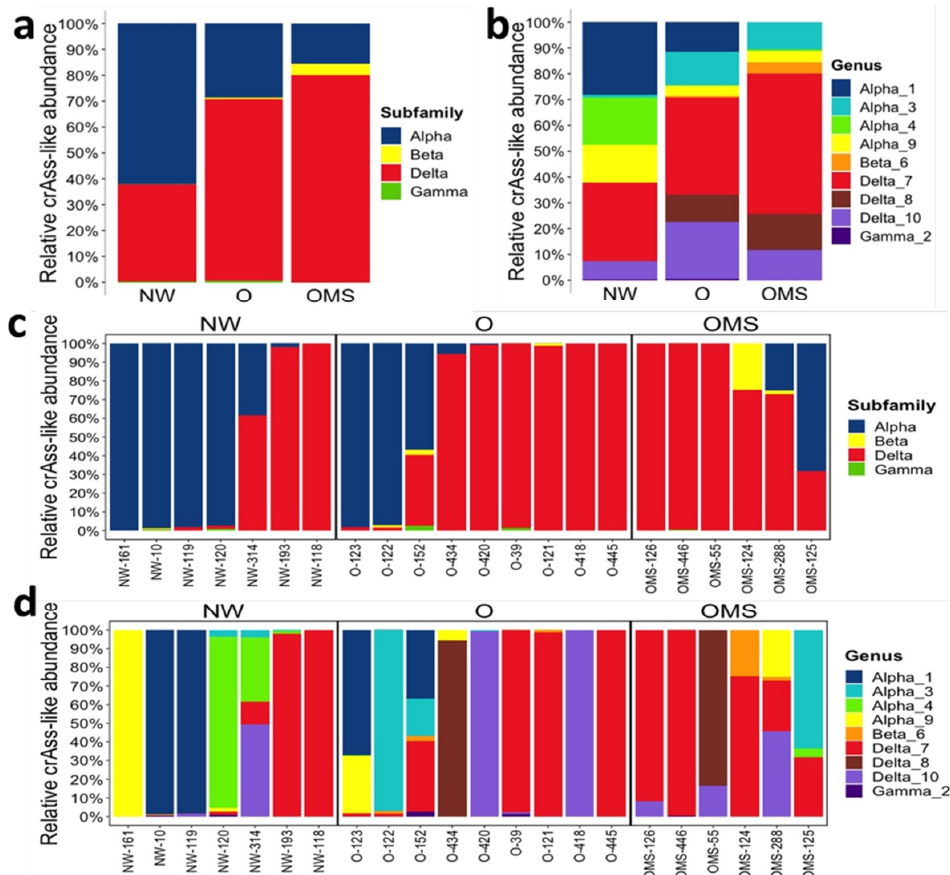
Figure 3. Relative abundance of crAssphage genomes grouped by taxonomy. ( a ) The average subfamilies and ( b ) genus per group; ( c ) the average subfamilies, and ( d ) genus per sample.